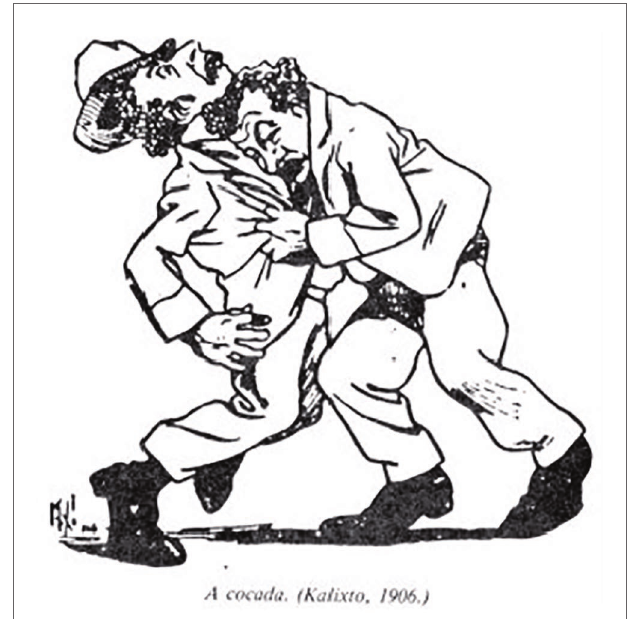
FIGURE 4 | The coconut